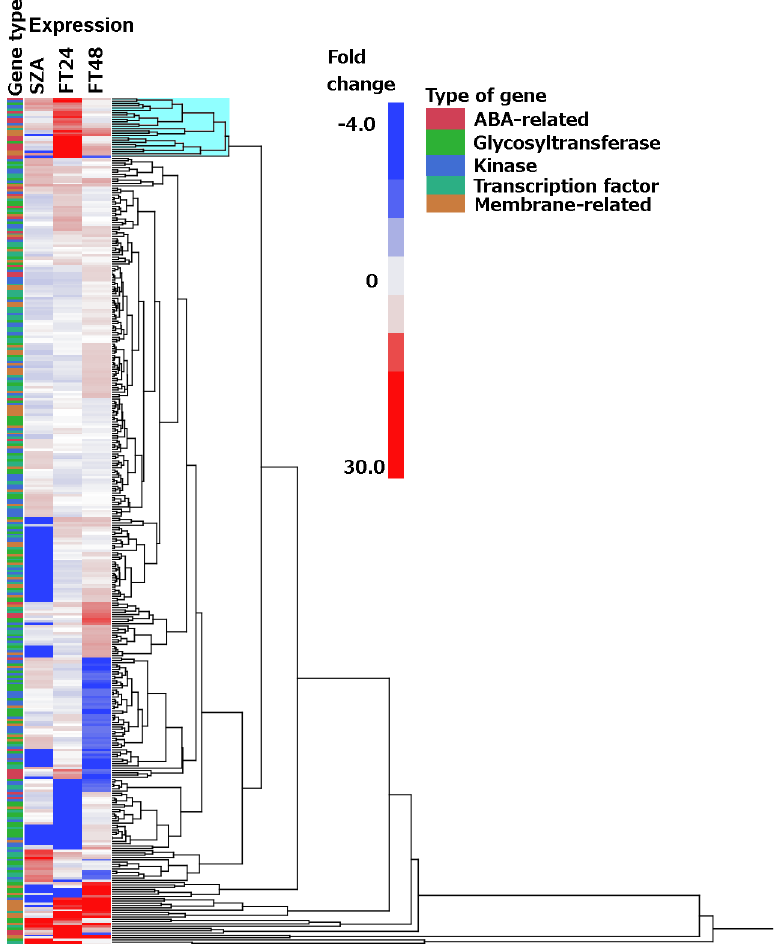
Fig 3. Expression level responses to freeze-thaw treatments of five classes of genes in wheat crown tissue. All genes shown were upregulated at least 2-fold in at least one of the treatments. SZA: subzero acclimation, − 3°C for 24 hours; FT24: freeze/thaw 24 hours, frozen to − 3°C for 24 hours then allowed to thaw at +3°C for 24 hours; FT48: freeze/thaw 48 hours, frozen to − 3°C for 24 hours then allowed to thaw at +3°C for 48 hours. The cluster of genes highlighted in blue at the top of the figure were uniquely, strongly upregulated only in response to the FT24 treatment (see text for details).